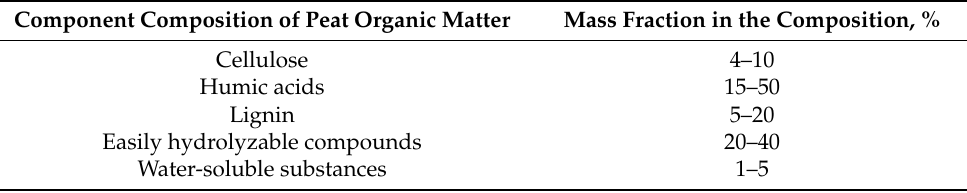
Table 1. The main components contained in the Greko-Ushakovskoye field